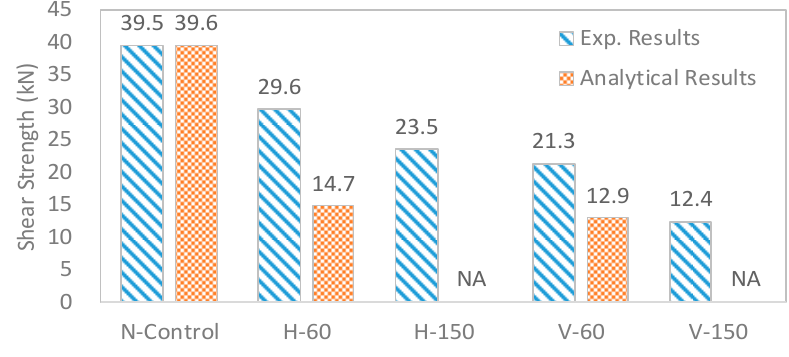
Figure 19. Obtained results of shear strength.